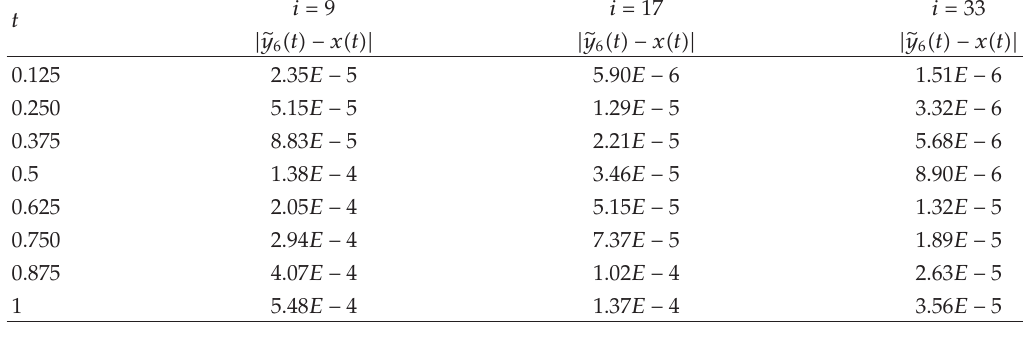
Table 2: Absolute errors for Example 4.2.